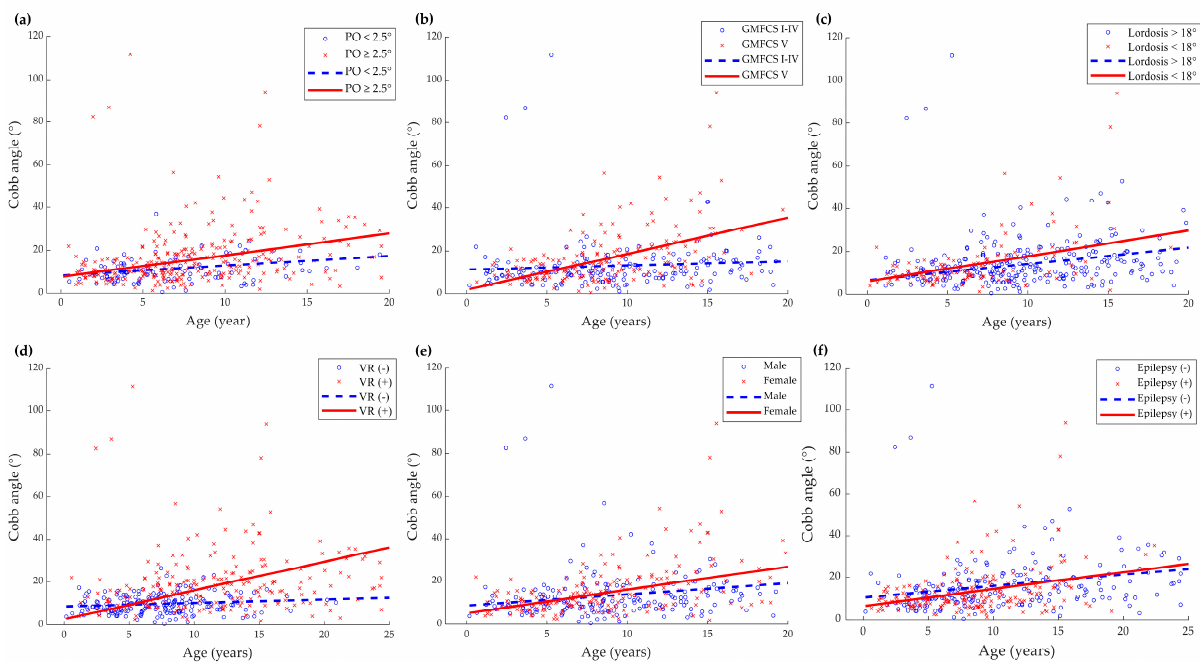
Figure 2. Subject-specific (scatterplot) and predicted progression line of Cobb angle (°) versus age (years) according to clinical parameters: ( a ) pelvic obliquity (PO); ( b ) gross motor function classification system (GMFCS); ( c ) lumbar lordosis; ( d ) vertebral rotation (VR); ( e ) sex; ( f ) epilepsy. There was a significant increase in the progression rate of scoliosis in patients with PO ≥ 2.5°, GMFCS level V, vertebral rotation (Nash–Moe grade ≥ 1), and in female patients. Reduced lumbar lordosis (<18°) in ≥ 2 years of age and the presence of epilepsy did not significantly affect scoliosis progression.